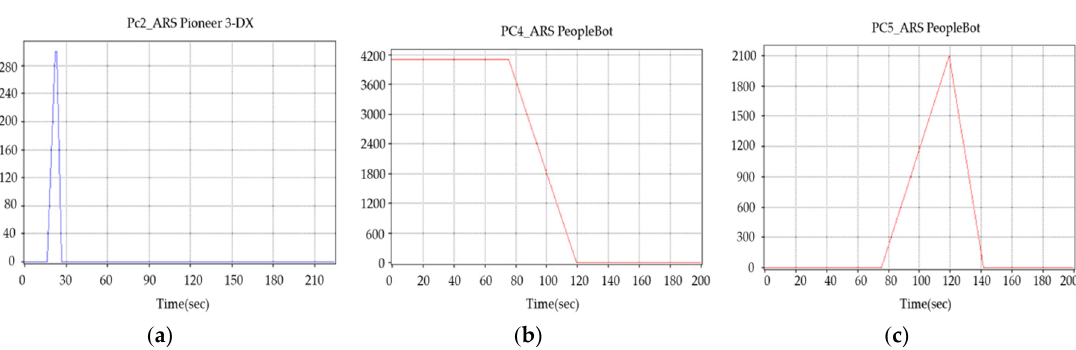
Figure 9. Synchronisation signals: ( a ) Sync1; ( b )Sync2 (see Figure 6). 4. Modelling and Control of the VSSs for Moments of the Image 4.1. Modelling and Control Structure The structure of a VSS is based on the following components: an autonomous system composed of a mobile robot equipped with a 5 or 6-DOF manipulator, a controller and a video sensor (web camera). The fundamental part of the architecture, the image-based controller requires a priori information about the behaviour of the system in order to minimize the error between a current configuration of visual features, f , and a desired configuration,